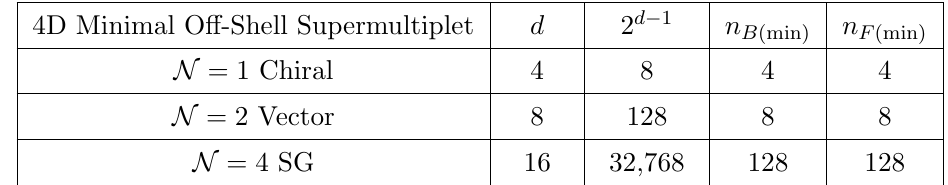
Table 2 . Number of independent components in maximally constrained